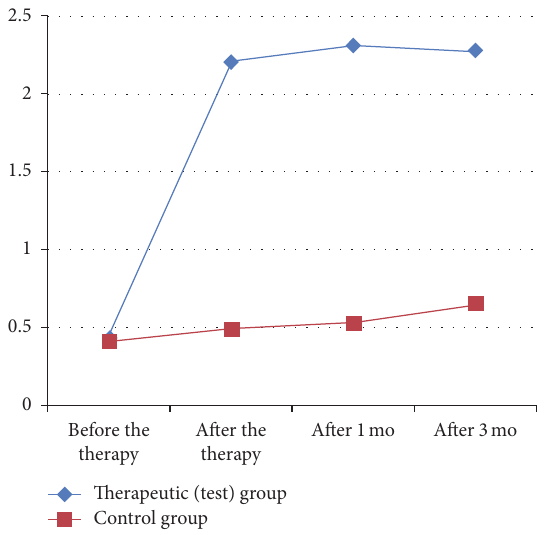
Figure 2: Dynamics of pain on palpation in the test and control group [VAS].